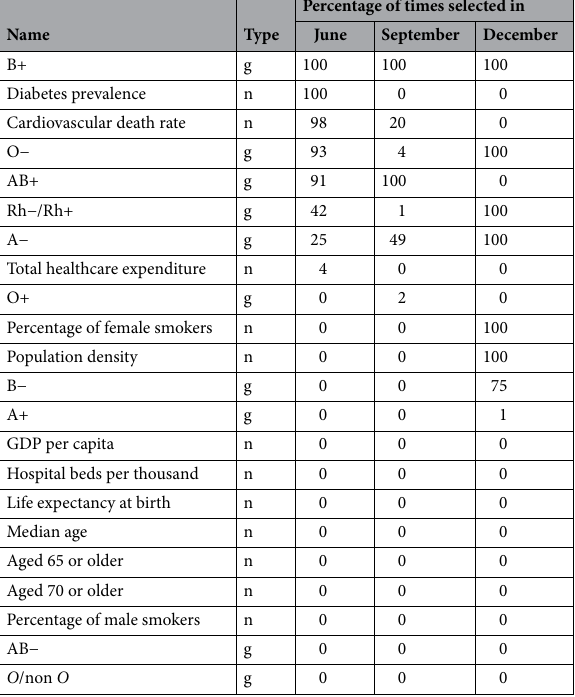
Table 3. Given the random nature of the Boruta algorithm we performed 100 runs of this algorithm on the same dataset with different seeds, then counted how many times each feature was selected by Boruta and reported counts in this table. Column “Type” has value “g” and “n” for “genetic” and “non genetic” features, respectively.